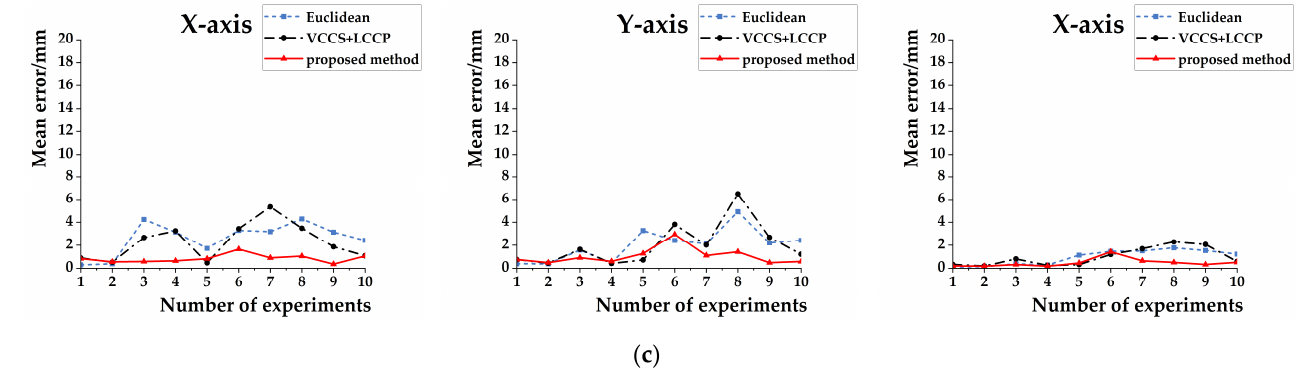
Figure 13. The mean error comparison. ( a ) Tee pipe 1. ( b ) Tee pipe 2 ( c ) Two-way elbow. Each group of ( a – c ) includes three figures of the mean errors on the XYZ-axis.